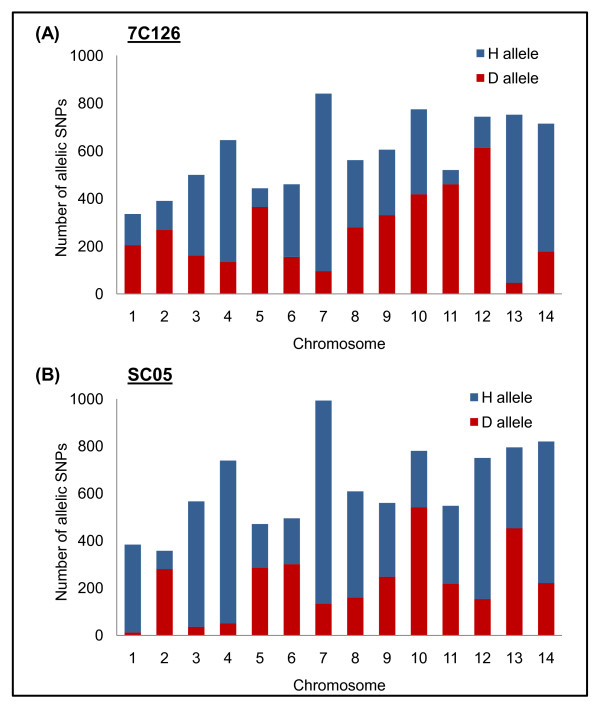
Genome-wide allelic SNP distribution. Summary of total bases used for allele calls (quality score ≥ 30, read number ≥ 10) and SNPs detected in each progeny (A-7C126, B-SC05). The progeny are predominantly HB3 parent like. For most positions a single base call was detected; however, mixed positions, i.e. alternate SNP positions were also detected (7C126-0.1%, SC05-0.09%). Of the high confidence single base calls, approximately 8,000 alleles were detected for each progeny line. Interestingly, approximately 0.001% of the SNPs were putative de-novo SNPs that differed from both parents.